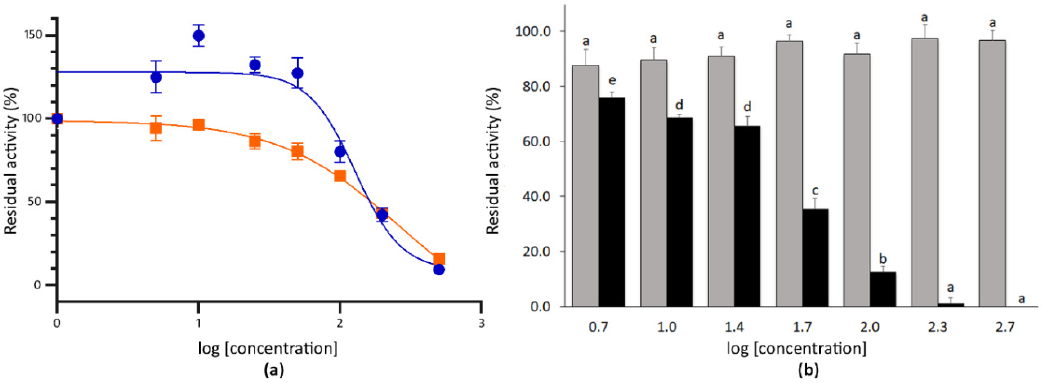
Figure 3. ( a ) Dose–response curve for the methanolic extracts of mustard seeds (blue circles) and wall rocket leaves (orange squares). Each point represents the average value and SE for the residual activity of the 3CL Pro (%) at extract concentrations between 5.0 and 500 µg mL − 1 ( n = 4). The 100% of residual activity is the activity of the 3CL Pro when no inhibitor is added. ( b ) Mean residual activity and SE of 3CL Pro (%) determined after the co-incubation with 5.0–500 µg mL − 1 of sinigrin (grey) and allyl isothiocyanate (black) standards ( n = 4). Different letters indicate significant differences in the 3CLPro residual activity for sinigrin or allyl isothiocyanate treatments according to two separate Student–Newman–Keuls tests at p < 0.05.